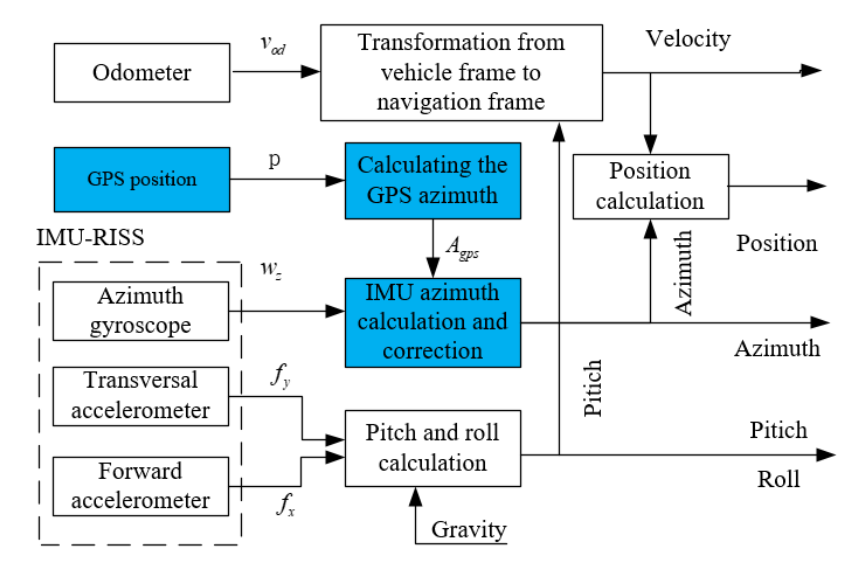
Figure 1. Structure diagram of the enhanced RISS